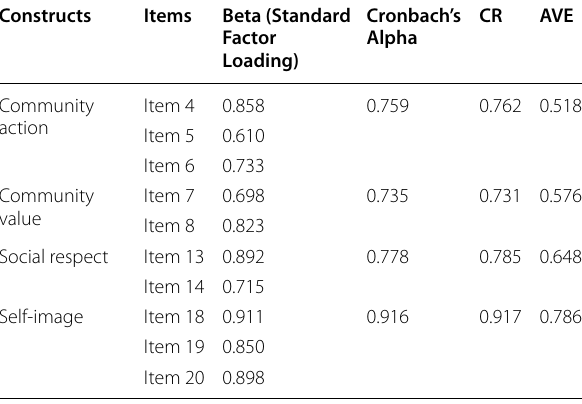
Table 4 Model summary for Model